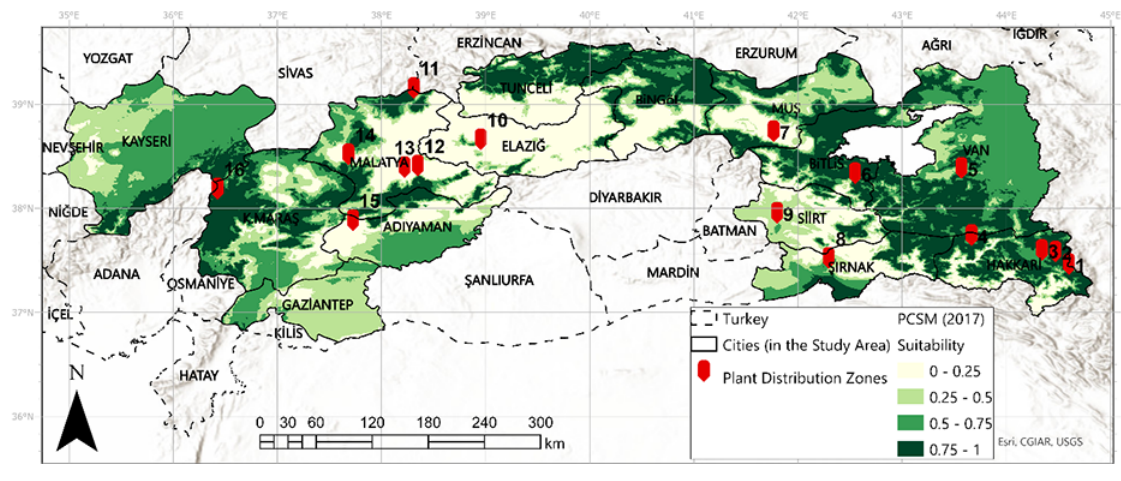
Figure 4 Climatic suitability of Fritillaria imperialis for current conditions (interpolations of observed data, representative of